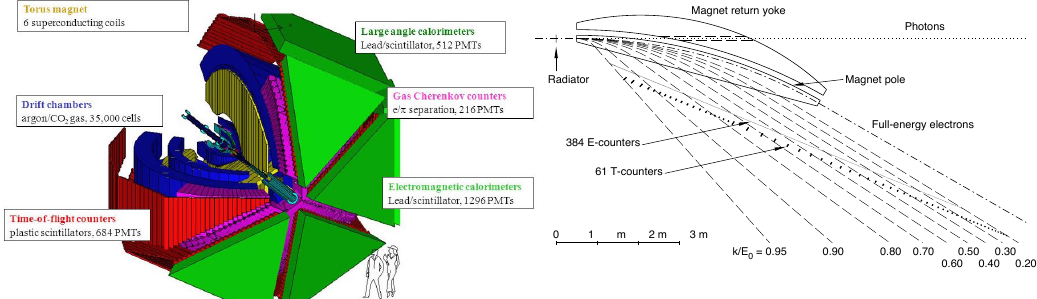
Fig.23. HallBphoton-taggingsystem.